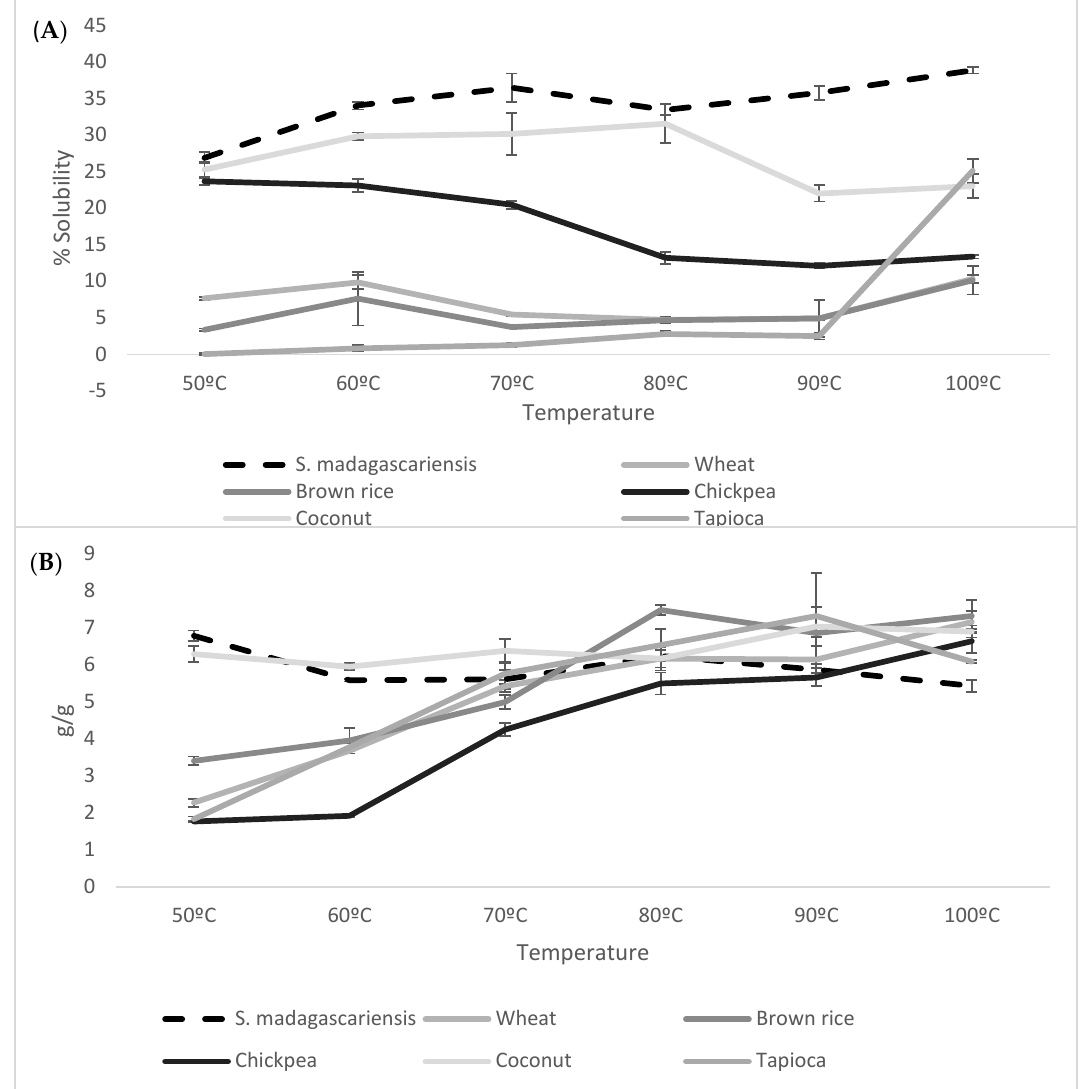
Figure 2. Solubility ( A ) and swelling power ( B ) of Strychnos madagascariensis seed compared to commercial flours, at varying temperatures. The error bars indicate the LSD values for each of the samples.